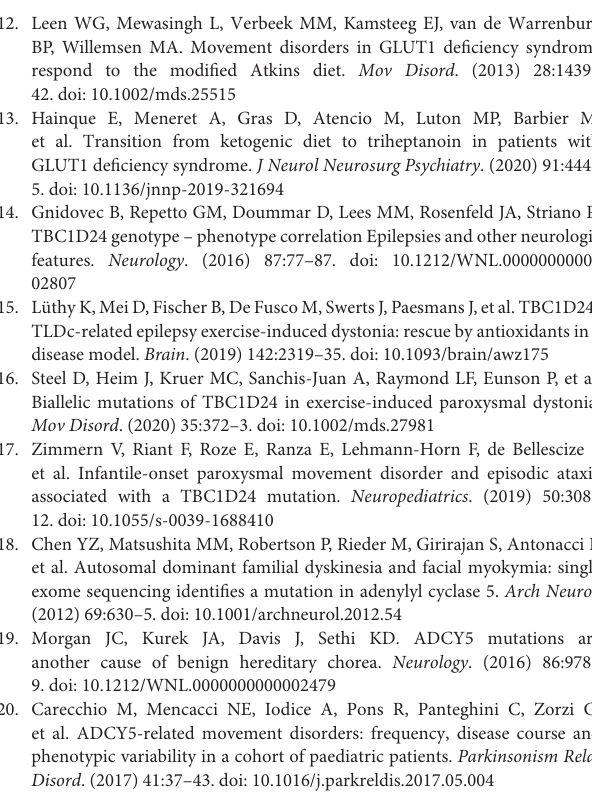
Figure 1 was created using Servier Medical Art templates, which were licensed under a Creative Commons Attribution